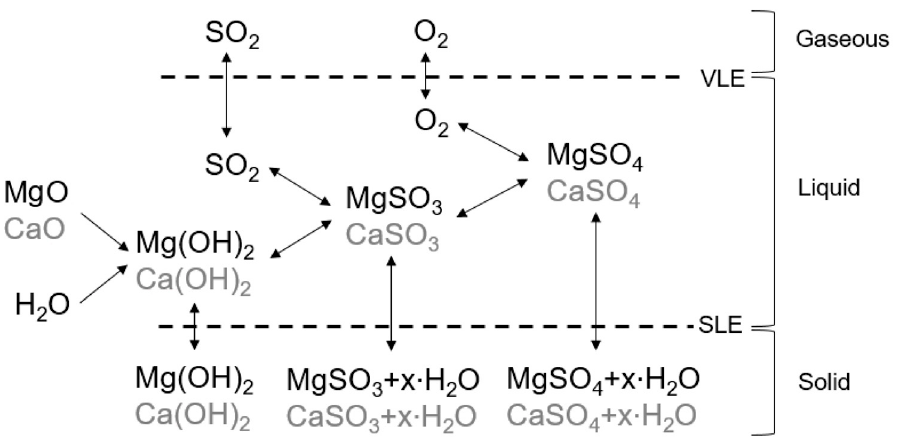
Figure 1. Chemical system leading to precipitations in the MgO-CaO-H 2 O-SO 2 -O 2 system. SO 2 and O 2 from the gas phase dissolve into the liquid phase according to the Vapor- Liquid-Equilibrium (VLE). The presence of Mg + from dissolved Mg(OH) 2 (see Section 2.5) and the presence of SO 3 —from dissolved SO 2 in the liquid phase lead to the